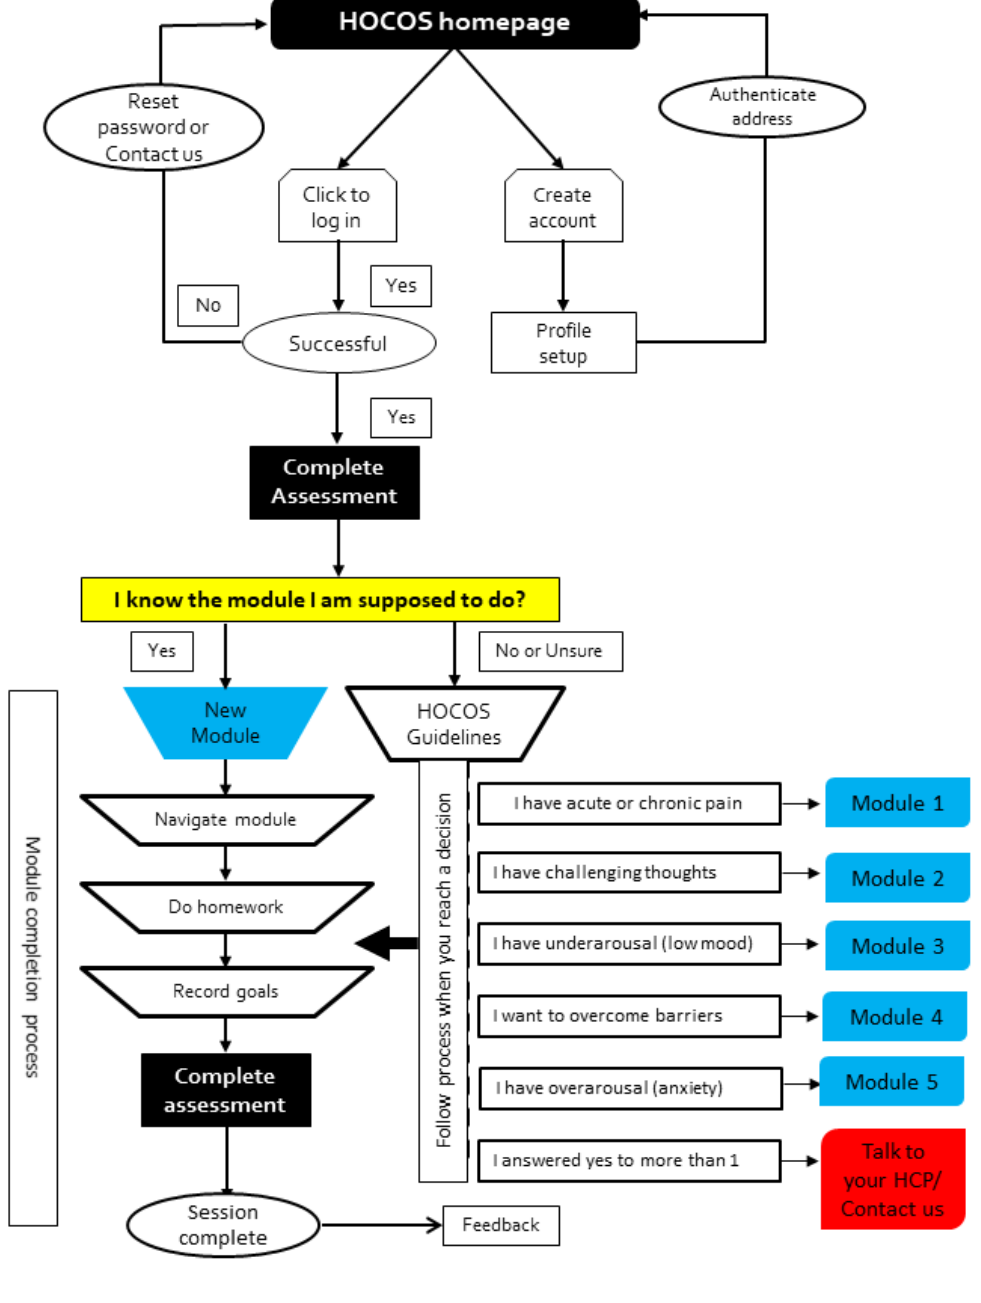
Figure 2. Navigation workflow of the Hand Therapy Online Coping Skills (HOCOS) training program. HCP: health care